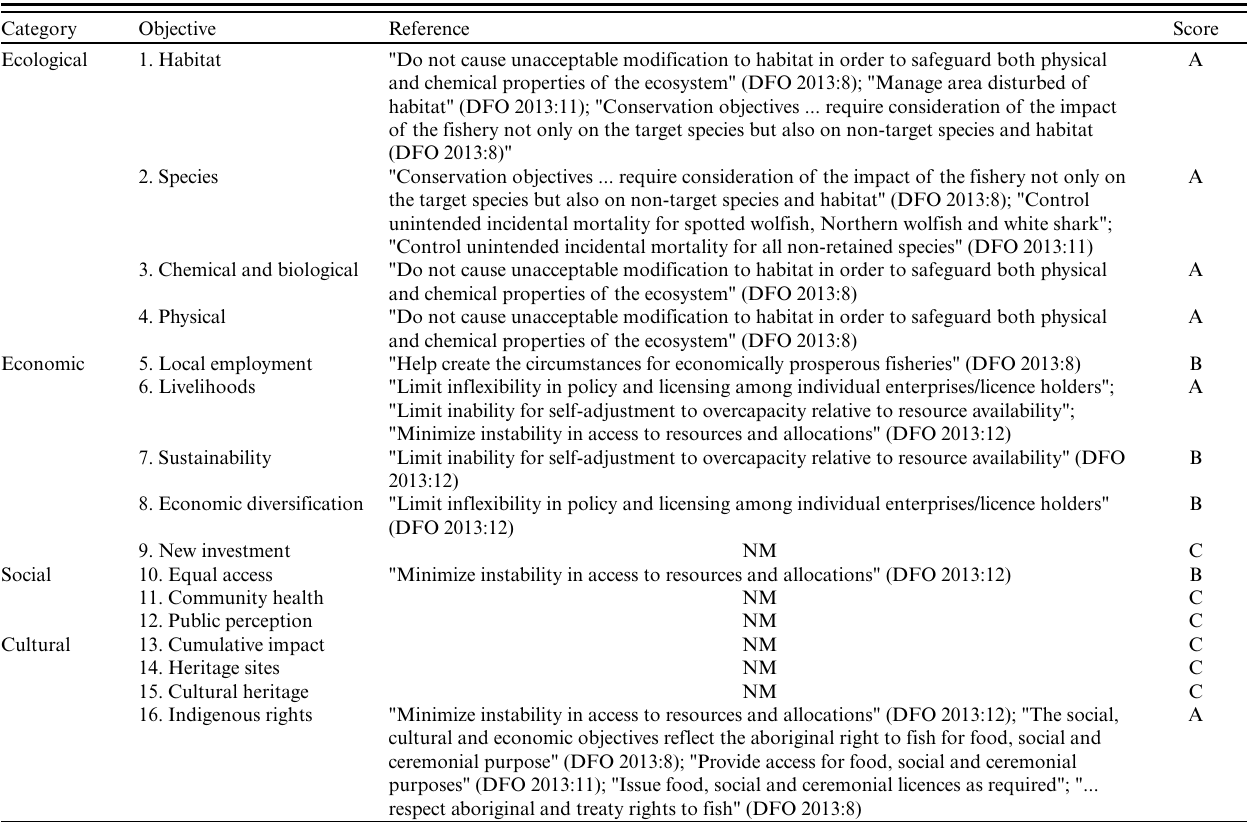
Table 3 . Desktop Community Values Criteria (CVC) evaluation of 2013 Herring Plan. DFO, Department of Fisheries and Oceans; NM, no